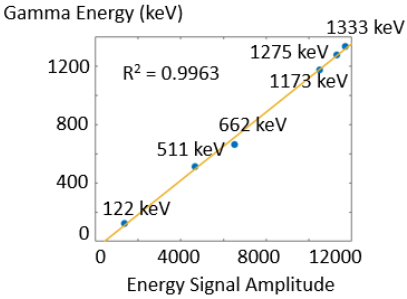
Figure 7. Energy spectrum in detector calibration (the blue line is the measured data and the red line is the Gaussian fitting of the energy peak). Figure 8. Energy response linearity in the single crystal and typical energy response fitting result.